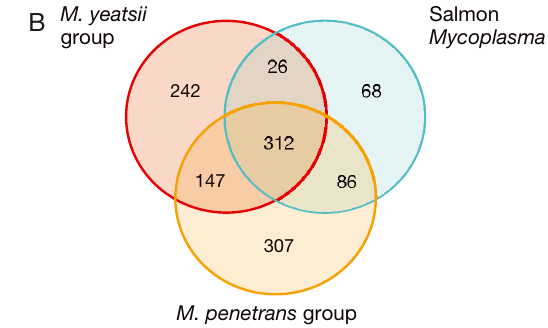
Fig. 6. Genome comparisons. (A) Each dot cor- responds to a genome, either complete or pre- dicted based on assembled contigs. Distances are Jaccard distances based on annotated cod- ing genes in each genome, and plotted using multidimensional scaling (principal coordinate analysis). Genomes close to each other have similar gene content. Some, but not all, of the genomes are labelled with their name. (B) Venn diagram for the Mycoplasma groups re- lated to salmon Myco plasma . Numbers indi- cate unique genes within each